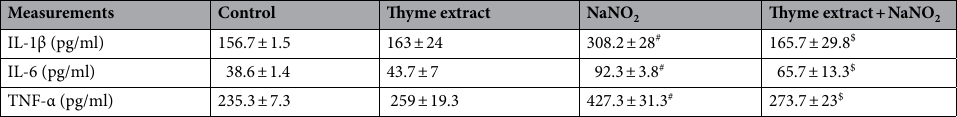
Table 6. Protective effects of Thymus vulgaris extract against NaNO 2 induced changes in proinflammatory cytokines. Values are means ± SEM for 7 different mice per each experiment. Values are statistically significant at # p < 0.05 versus Control and Thyme Extract groups. $ p < 0.05 versus NaNO 2 . NaNO 2 : Sodium nitrite.